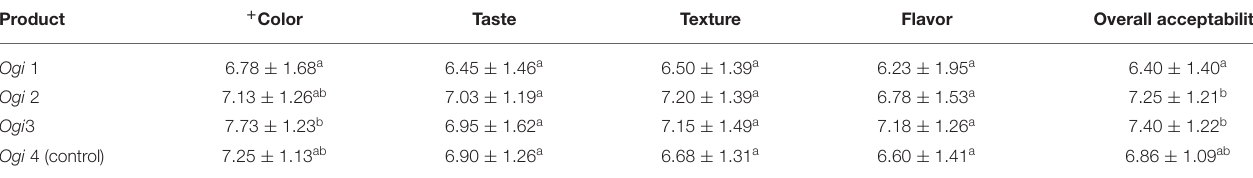
TABLE 7 | Sensory attributes of ogi porridge from provitamin A-biofortified maize genotypes and yellow landrace.